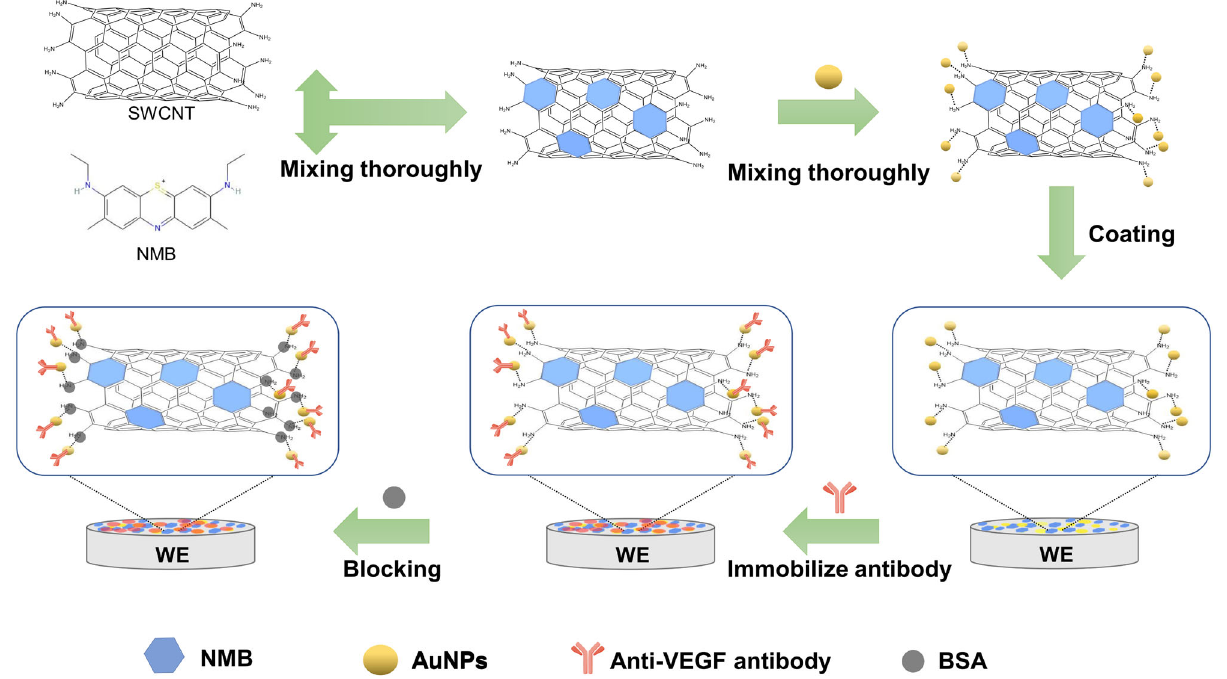
Fig. 8 Nanocomposite modi fi cation process of the VEGF-C immunosensor. Schematic diagram of nano material modi fi cation. First, the single wall carbon nanotubes (SWCNT) and new methylene blue (NMB) were mixed. After that, gold nanoparticles (AuNPs) were modi fi ed on the